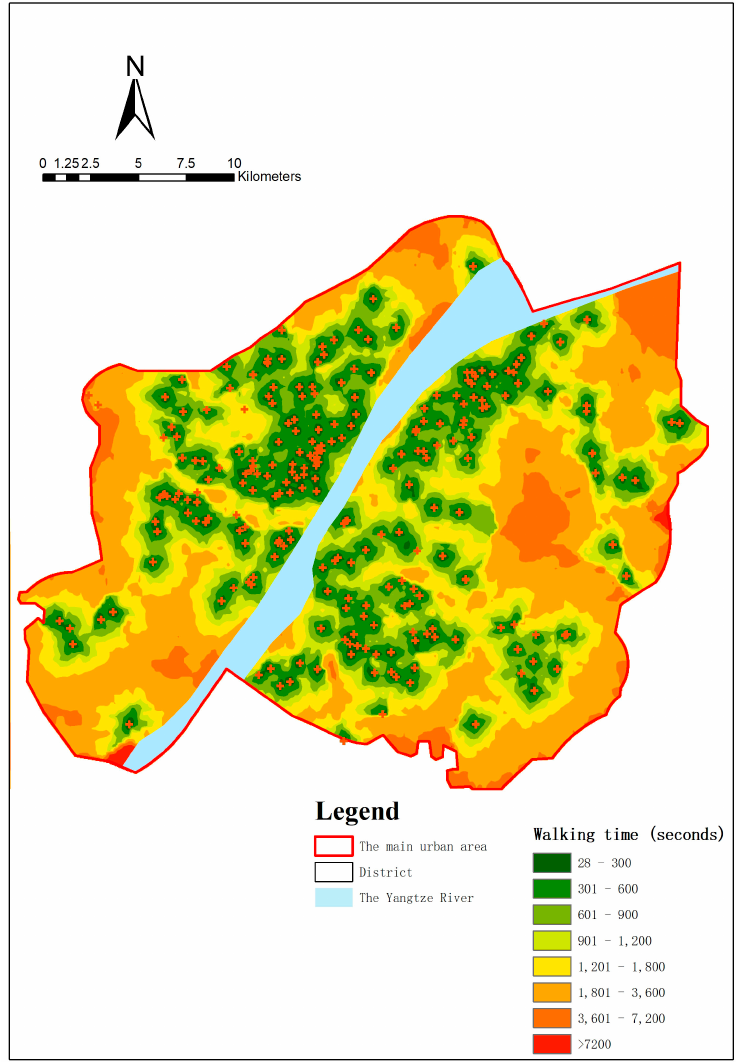
Figure 6. Actual service areas by walking.